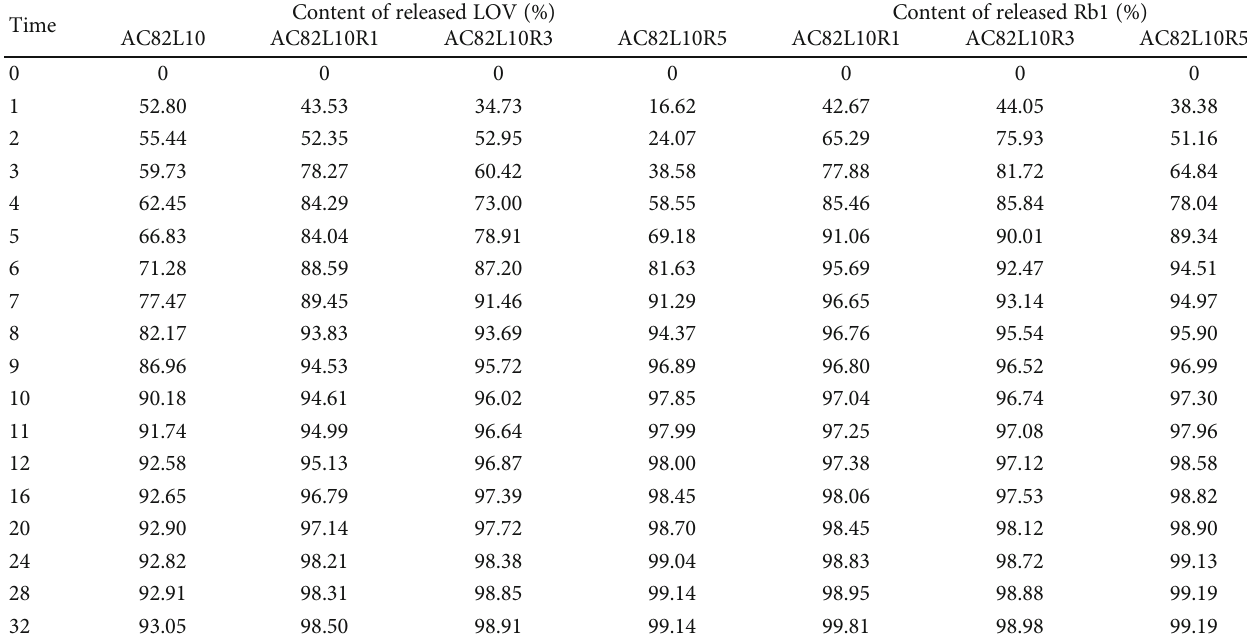
Table 6: The content of LOV and Rb1 released from AC82L10R x composite fi lms in pH 7.4 solution. Content of released LOV Time